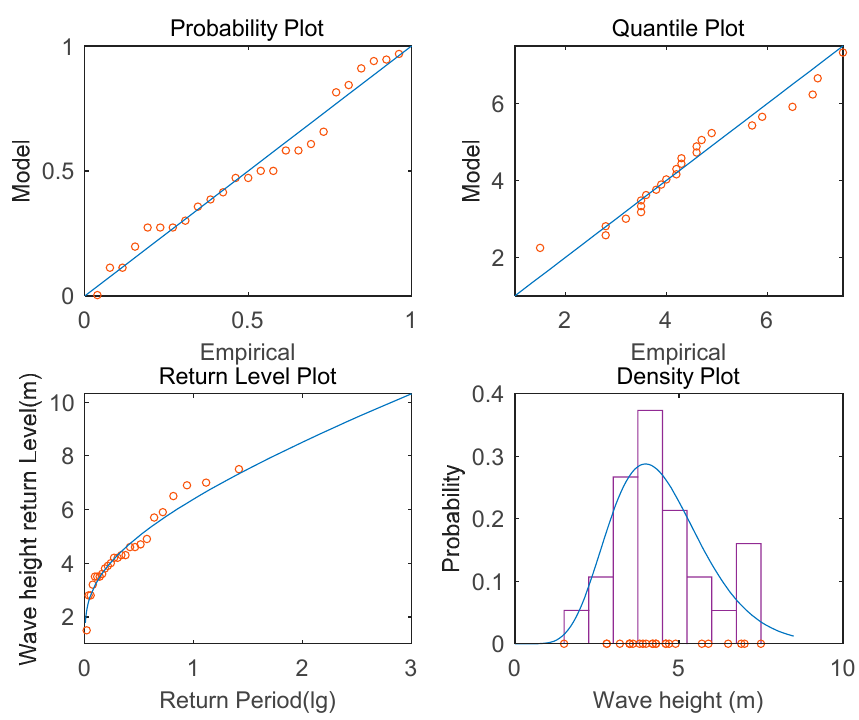
Figure 5. Inspection diagram of annual extreme wave height data of Pearson-III distribution.